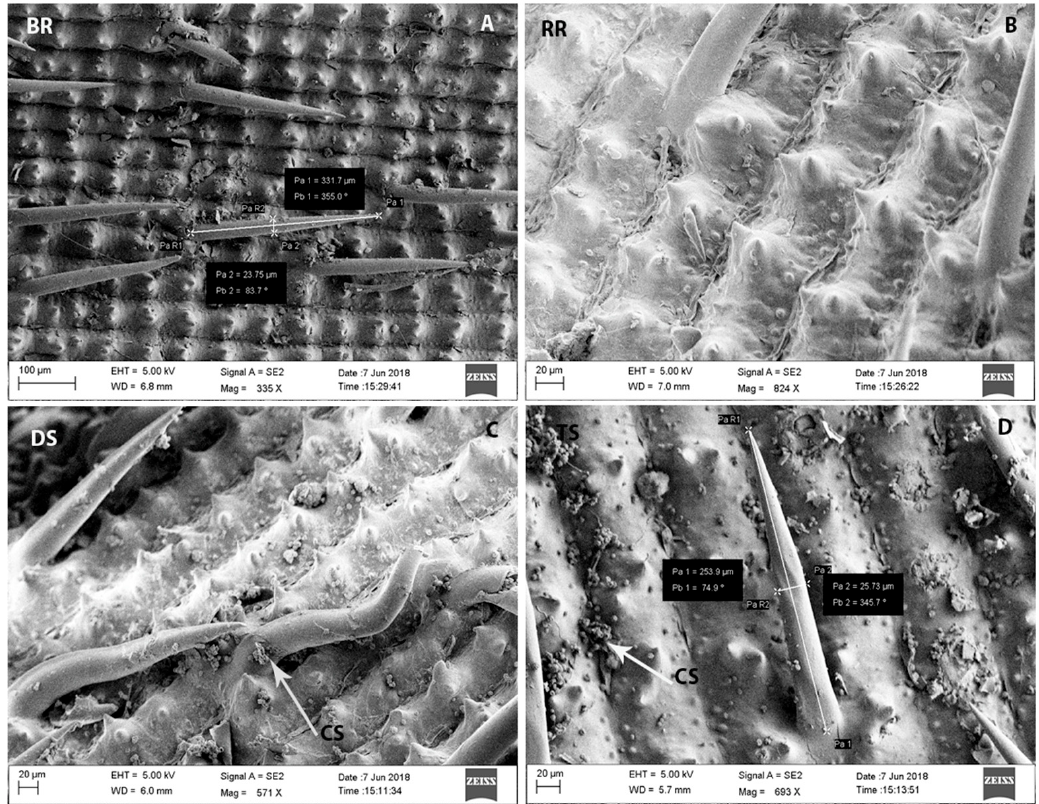
Figure 2. SEM micrographs for varieties of rice grain surfaces: ( A , B ) Resistant varieties (BR and RR) have spikes of different sizes. ( C ) Susceptible Dharam rice (DS). ( D ) Susceptible Thangjim rice (TS). Varieties (DR/DS and TR/TS) are infected with U. virens bearing chlamydospores (CS/C). The scale bar for ( A ) = 100 μ m and ( B – D ) = 20 μ m. Note: Pa 1, Pa 2 (Length of the spike, and the angle respectively), Pb 1, Pb 2 (Length of the spike, and the angle respectively), Pa R1, and Pa R2 (The lines get named by default in the SEM machine).